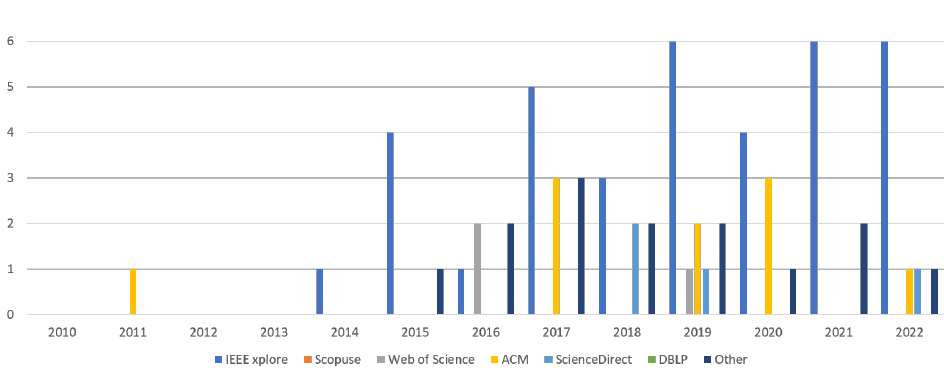
Figure 7. Distribution of papers by year and digital